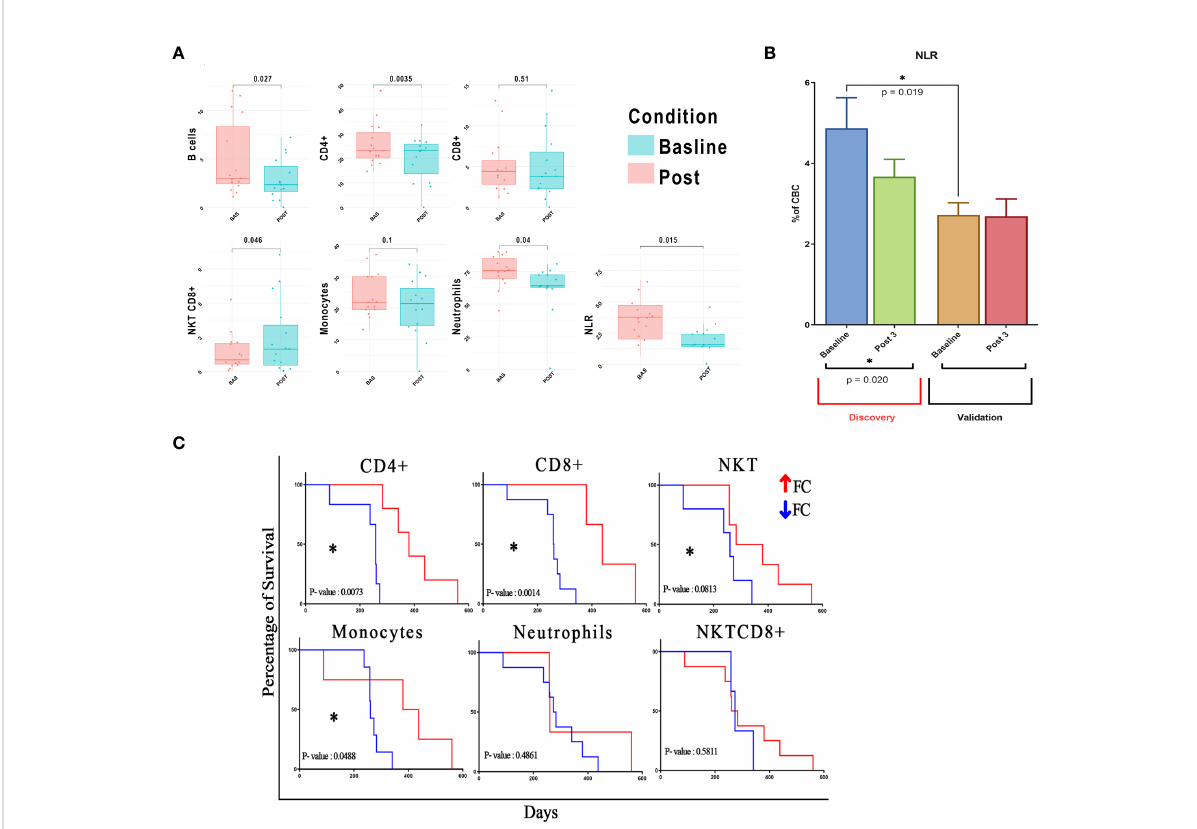
FIGURE 2 Correlation of different cell clustering and mNSCLC patient survival. Post-treatment fold change of previously identi fi ed cells is calculated and used for downstream analyses. (A) Values of seven fundamental cell clusters before and after therapy are shown as grouped dot plot, paired Student ’ s t-test is used for the analysis of each cluster in the different treatment conditions, and clusters with p-value < 0.05 were considered as signi fi cant. y-Axis represents % of cells on total lymphocytes for B/T/NKT cells, total cellularity for monocytes and neutrophils, and an absolute number for NLR. (B) NLR calculation in two different study centers to demonstrate baseline differences. (C) Survival analysis based on population fold changes; p-value < 0.1 considered as trend, and p-value < 0.05 considered as statistically signi fi cant. mNSCLC, metastatic non-small cell lung cancer; NLR, neutrophil-to-lymphocyte ratio. *=